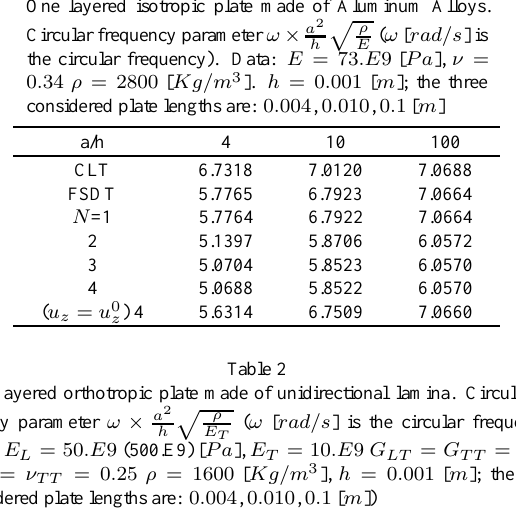
Table 1 One layered isotropic plate made of Aluminum Alloys.